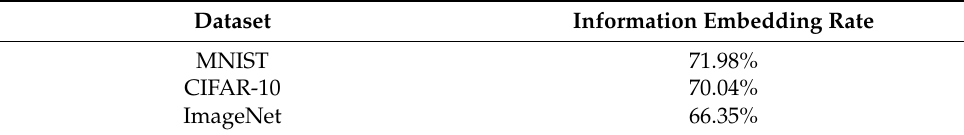
Table 7. The information embedding rate is the rate of all parameters of the model and the amount of information embedded in the